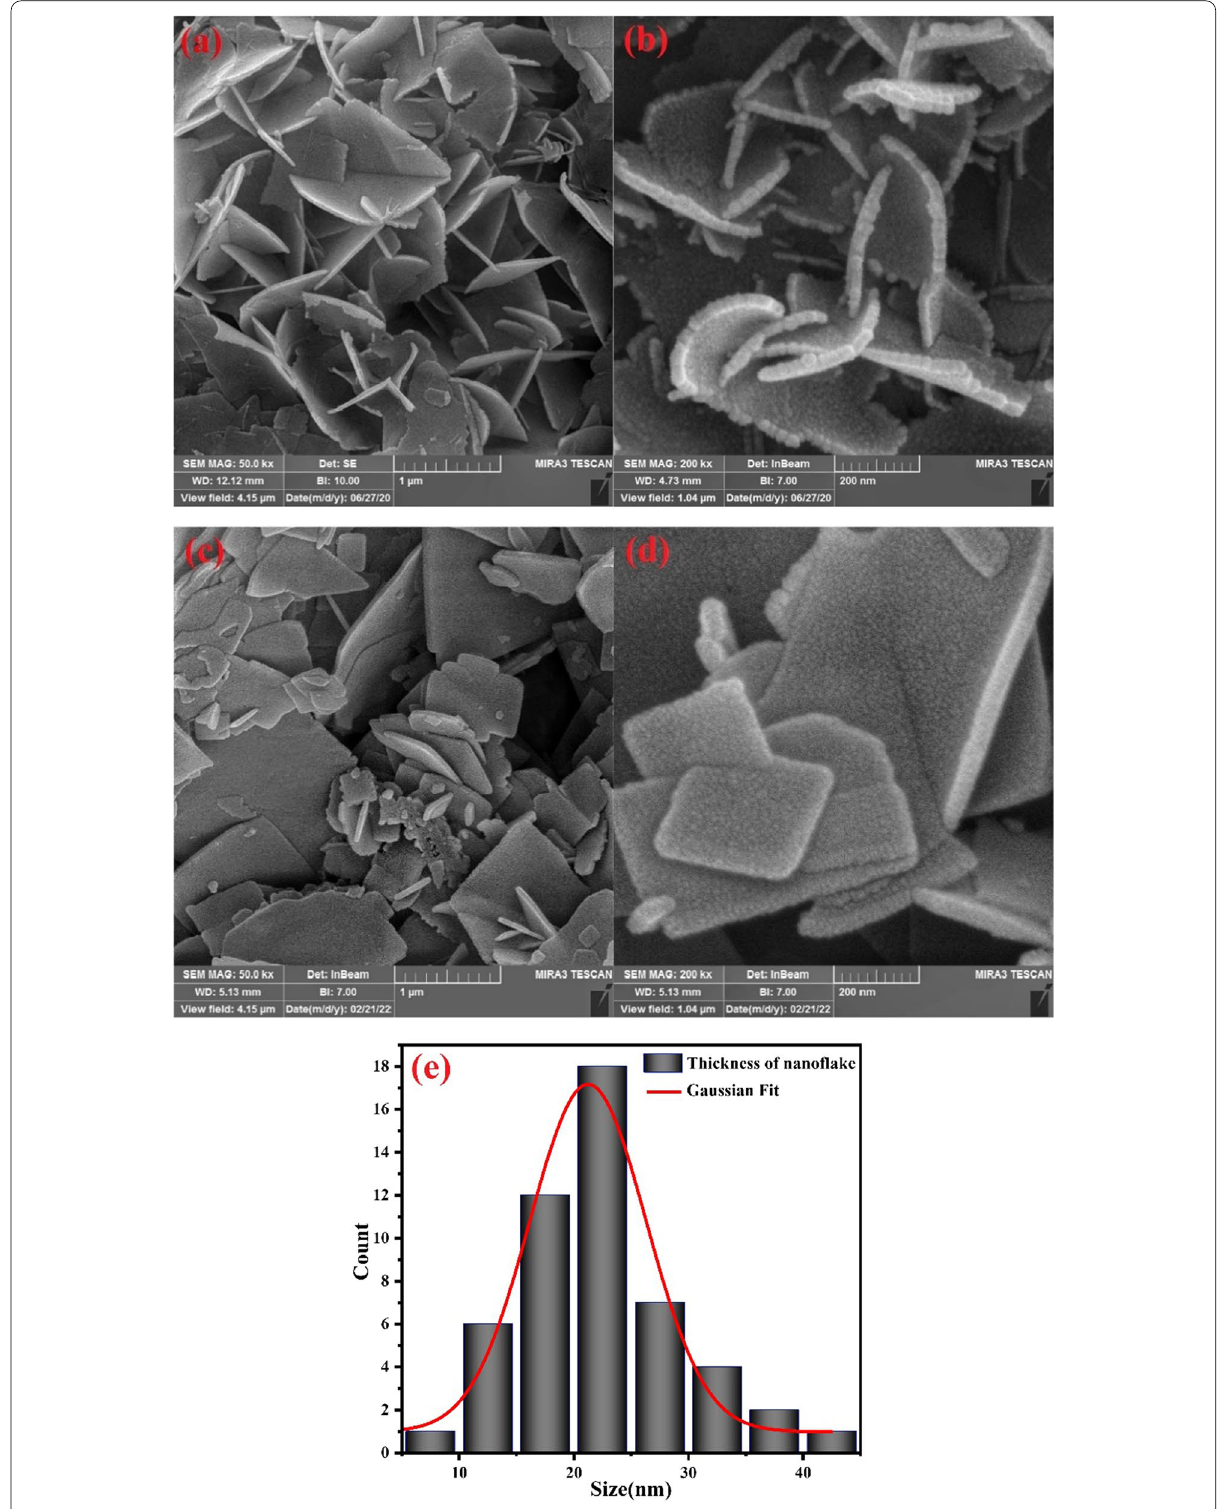
Fig. 3 FE-SEM images of synthesized nanostructures by electrical arc discharge in a , b urea solution, c , d water, and e size distribution histogram of Bi 2 O 3 /Bi 2 O 2 CO 3 /(BiO) 4 CO 3 (OH) 2